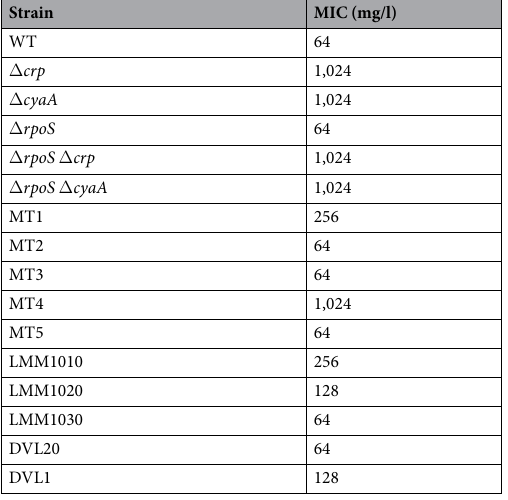
Table 2. Fosfomycin MICs obtained for E. coli MG1655 WT and its indicated